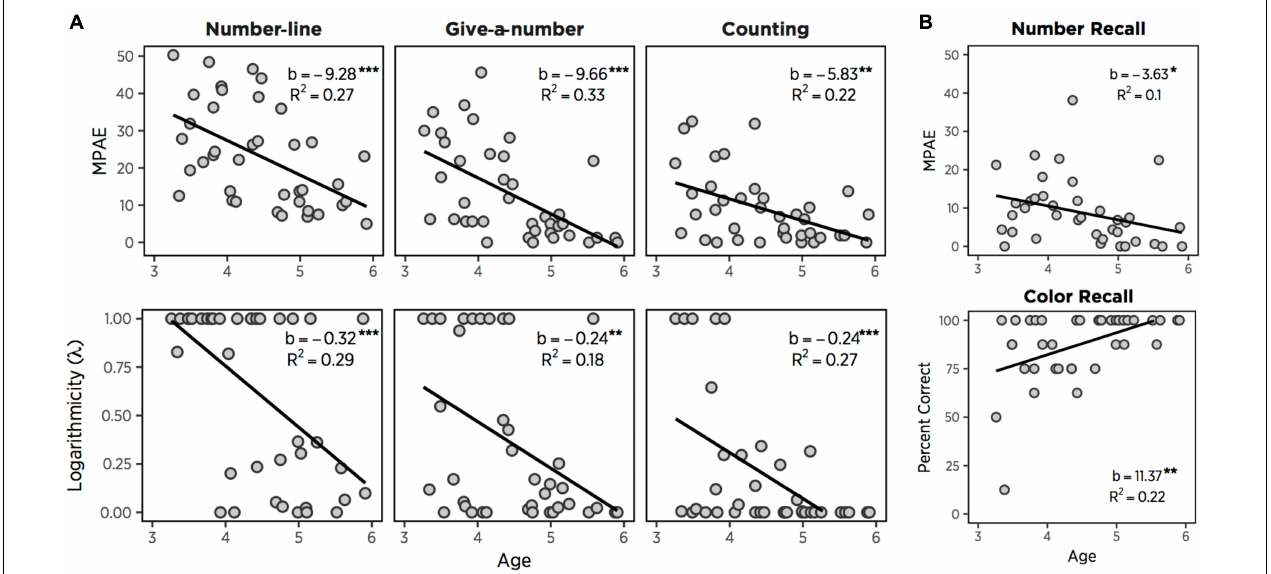
FIGURE 1 | MPAE and logarithmic components ( λ ) as a function of age in three numerical tasks (A) . MPAE of number recall and the percent correct of color recall (B) . ∗ p < 0.05, ∗∗ p < 0.01, ∗∗∗ p < 0.001.